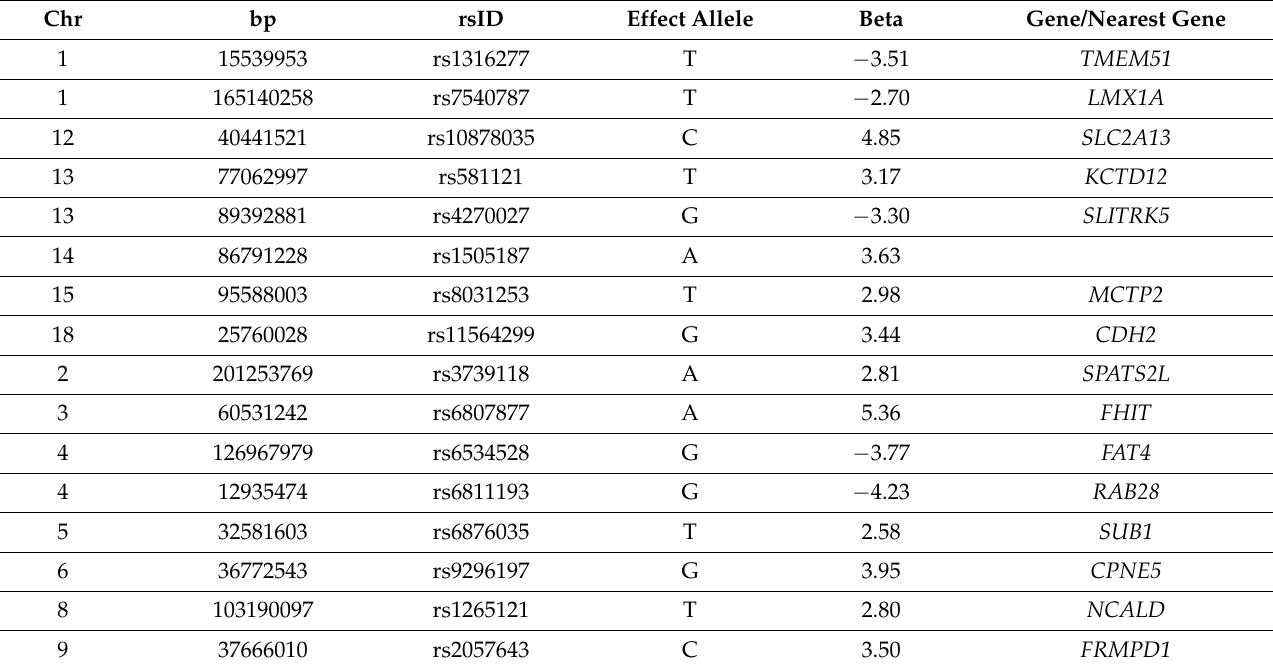
Table 1. SNPs included in the polygenic risk score (PRS) calculation for the bronchodilator response (BDR) (with Betas from Himes et